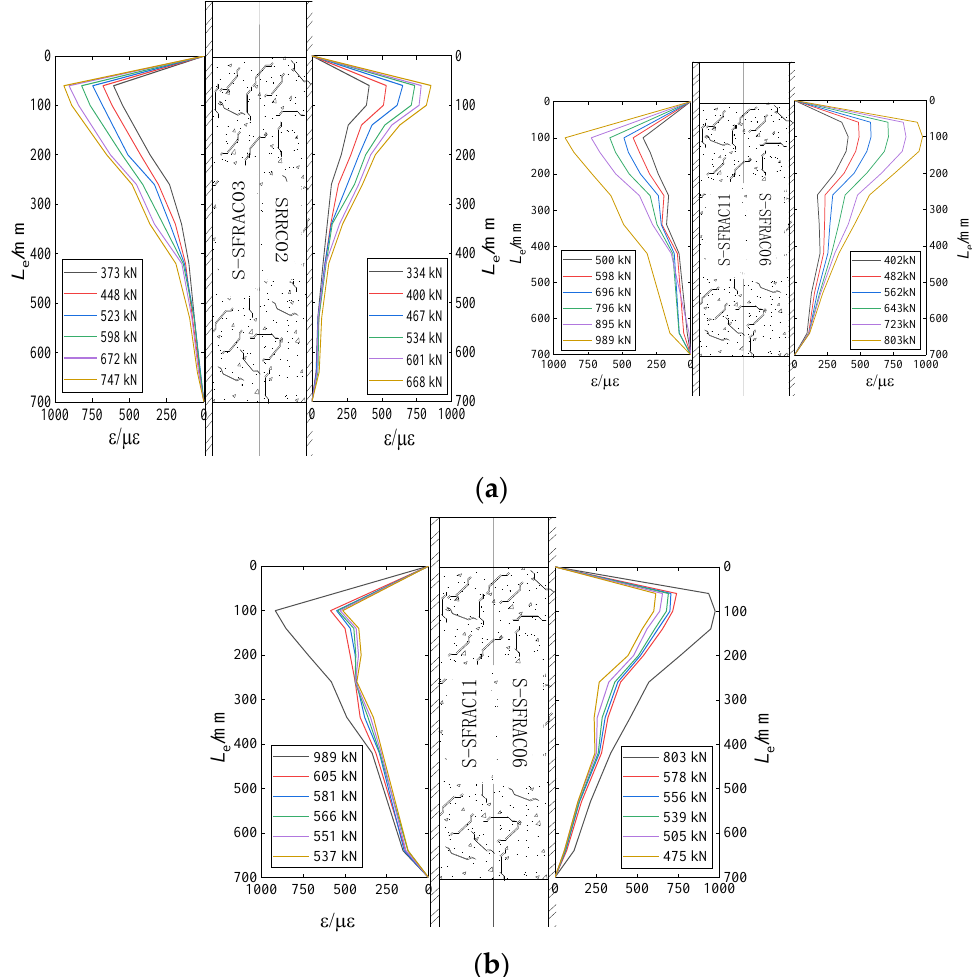
Figure 11. Section steel flange strain distribution. ( a ) Load increase section. ( b ) Load decrease section.